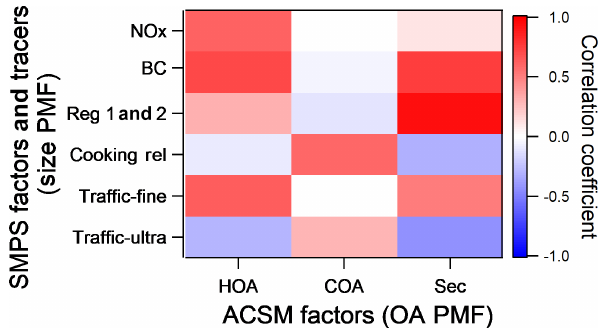
Figure 9. Pearson correlation coefficients ( r ) of ToF-ACSM vs. SMPS factors and BC and NO x time series. Traffic-ultra denotes the ultrafine particles related to traffic, traffic-fine denotes the fine particles related to traffic and cooking rel denotes the particles re- lated to cooking activities. Reg 1 and 2 denote the sum of particles related to regional sources type 1 and 2. Sec is the sum of SIA and